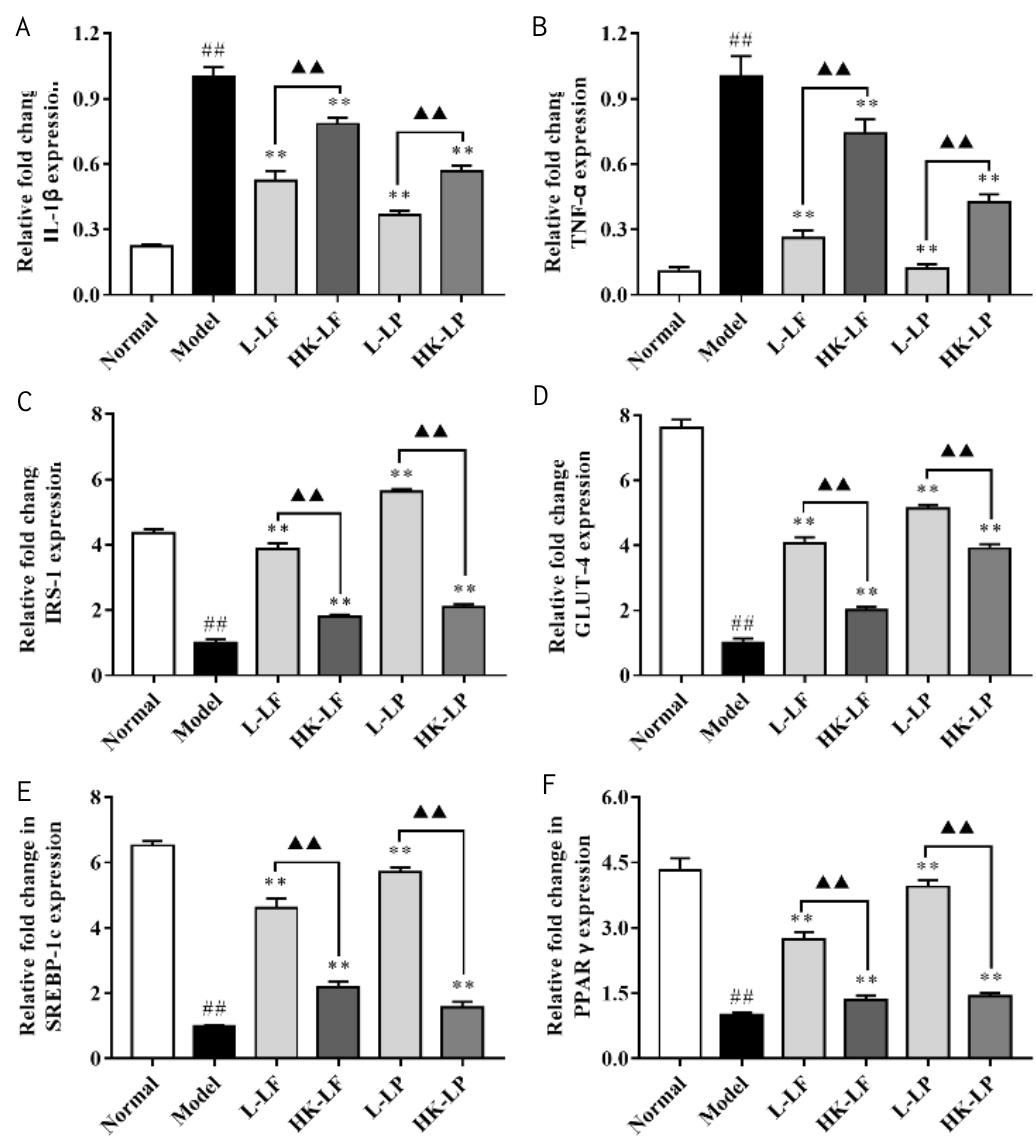
Figure 9. IL-1β ( A ), TNF-α ( B ), IRS-1 ( C ), GLUT-4 ( D ), SREBP-1c ( E ), and PPARγ ( F ) gene expression levels in the liver. L-LF: live LF group; HK-LF: heat-killed LF group; L-LP: live LP group; HK-LP: heat-killed LP group. ## P < 0.01 compared with Normal, ** P < 0.01 compared with Model, and ▲▲ P < 0.01.